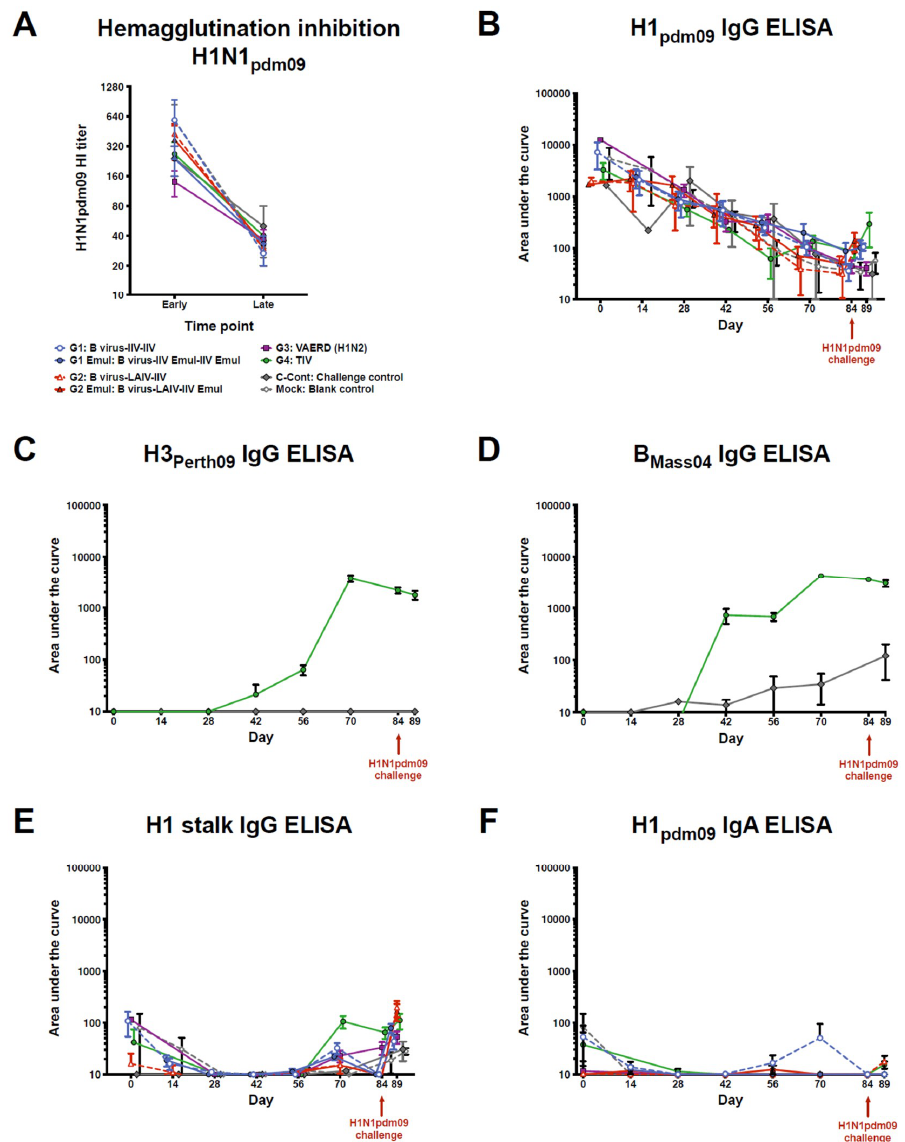
Figure 2. Serology after vaccination and infection. ( A ) Hemagglutination inhibition titers against pH1N1 were measured in the earliest available and the last pre-challenge serum samples from all pigs. The points indicate the mean titers for each group and the error bars show the standard error means. ( B – E ) IgG titers were measured by ELISA against different influenza virus HAs over time. Points indicate the mean area under the curve value for each group and the error bars show the standard error means. ( F ) IgA titers were measured by ELISA against pH1 over time. Points indicate the mean area under the curve value for each group and the error bars show the standard error means.